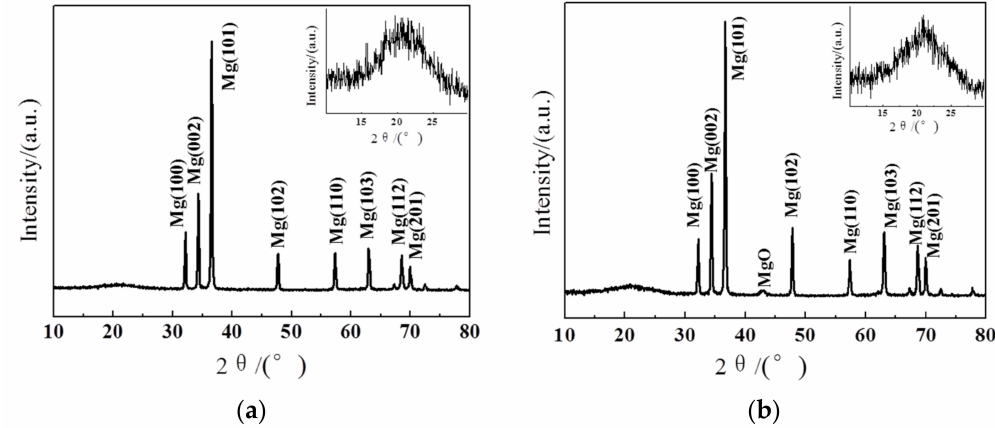
Figure 4. X-ray di ff raction (XRD) pattern of PCNS-reinforced Mg composite powders before ( a ) and after ( b ) PVP removal.